Question: Name the type of graph shown.
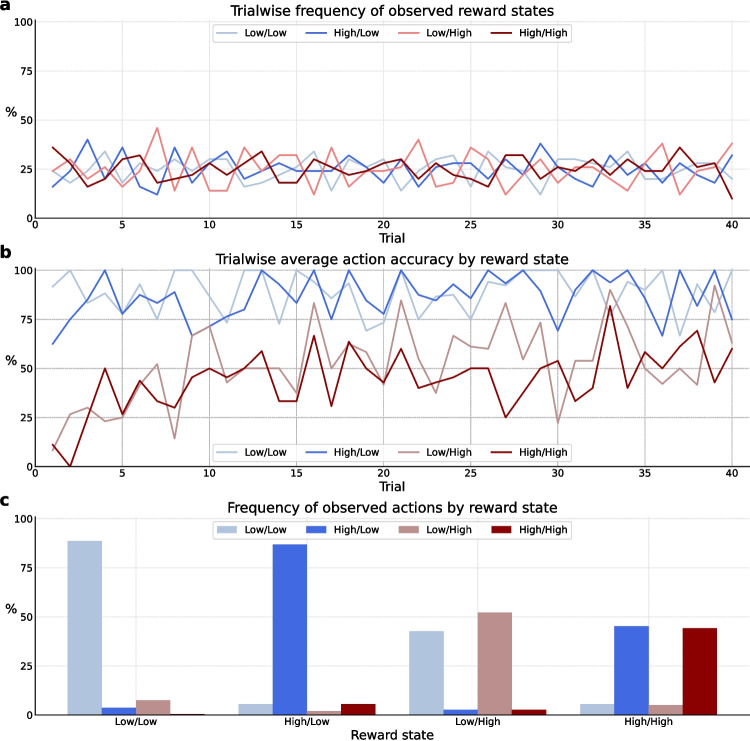
Answer: bar